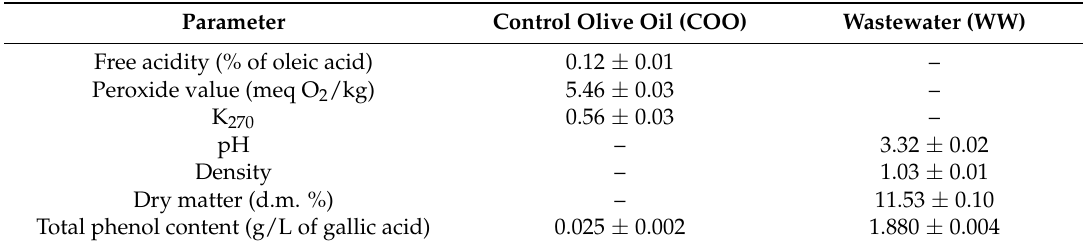
Table 1. Chemical composition control oil (COO) and wastewater